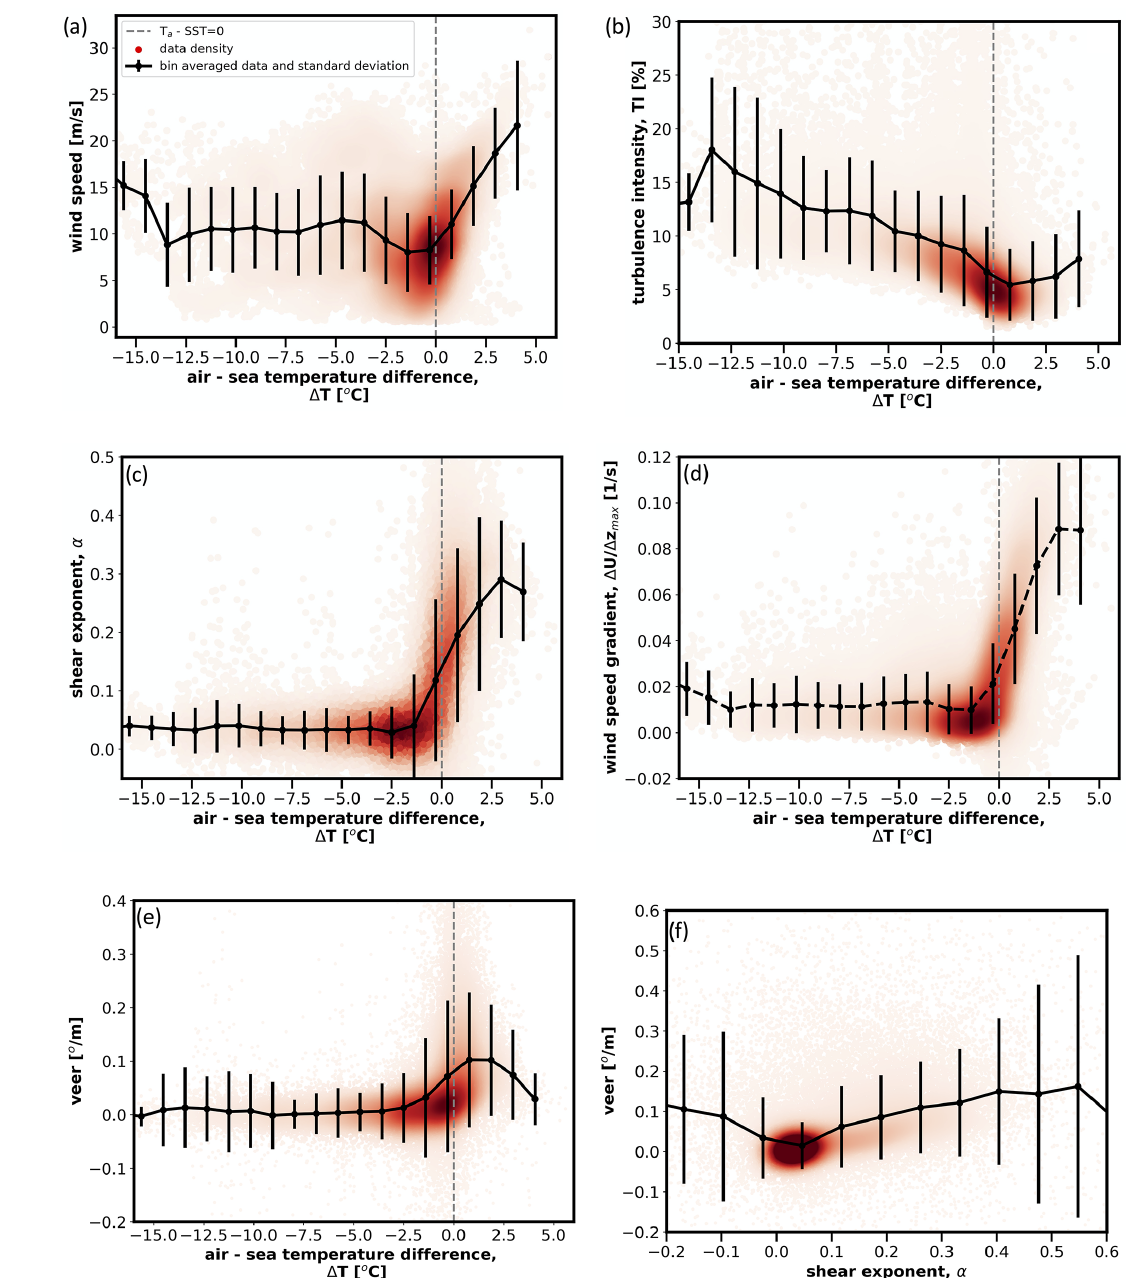
Figure 9. Wind characteristics as they depend on the air–sea temperature difference. Only NE buoy (Table 1) data are shown here. (a) Wind speed, (b) turbulence intensity, (c) wind shear exponent, (d) maximum wind speed gradient across the nominal rotor defined here (between 40 and 160m) and (e) wind veer. A relationship between the wind shear exponent and wind veer is provided in panel (f)